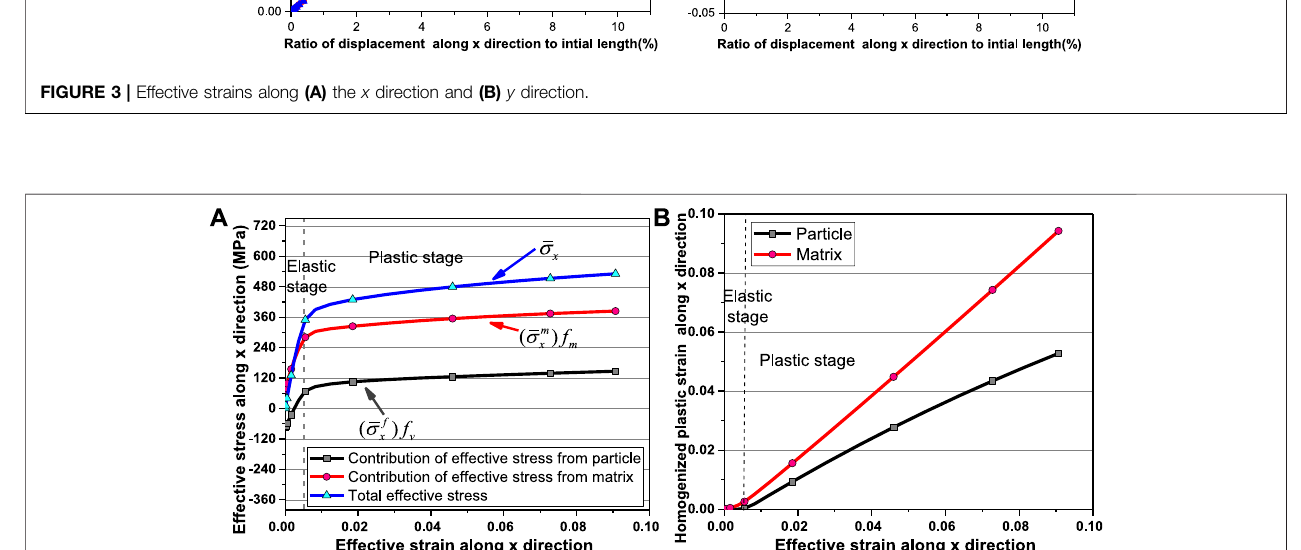
FIGURE 4 | (A) Effective stress/strain curves and the effective stress contributions and (B) the homogenized plastic strains along the x direction during the tensile test.